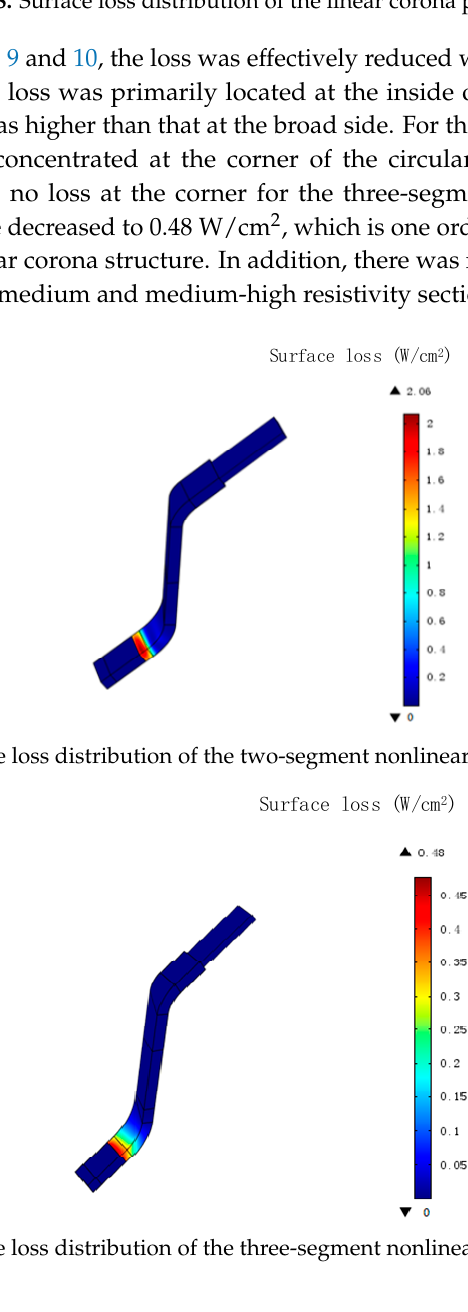
Figure 10. Surface loss distribution of the three-segment nonlinear corona protection layer.